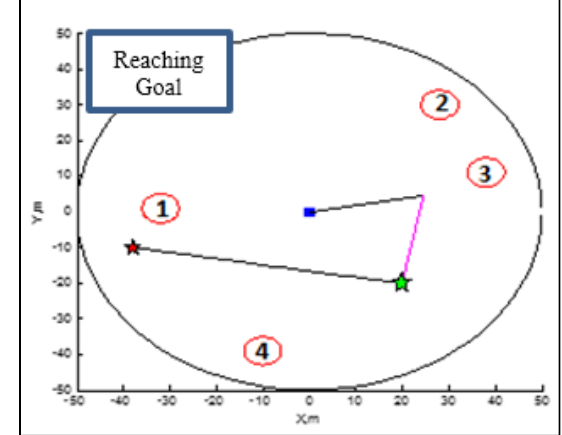
Fig. 9. The two-link robot arm result for the D* based on PSO path.